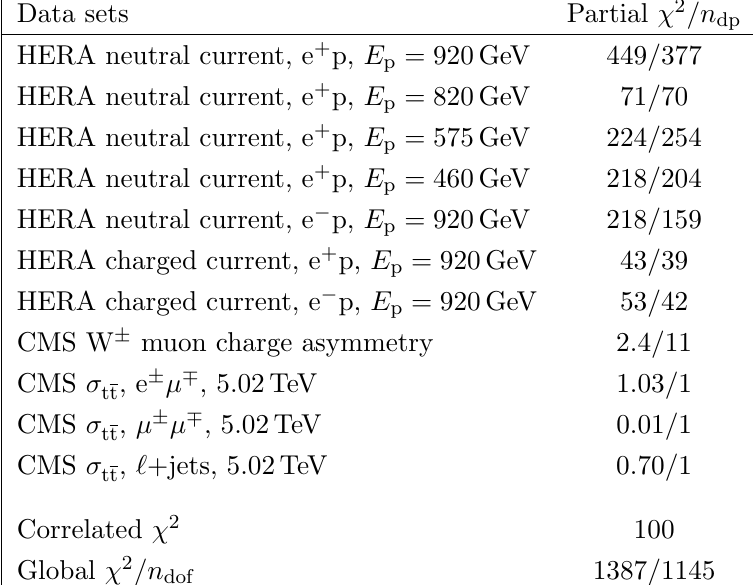
Table 5 . Partial (cid:31) 2 per number of data points, n dp , and the global (cid:31) 2 per degrees of freedom, n dof , as obtained in the QCD analysis of DIS data, the CMS muon charge asymmetry measurements, p and the (cid:27) results at s = 5 : 02 TeV from this analysis. For the HERA measurements, the energy tt of the proton beam ( E p ) is listed for each data set, with the electron/positron energy of 27.5 GeV. The correlated part of the global (cid:31) 2 value is also